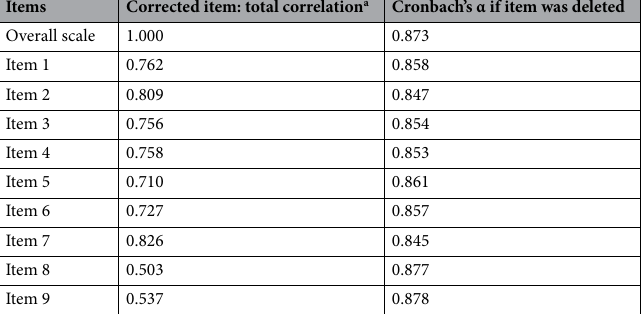
Table 2. The internal consistency of CAIT-C. CAIT-C Chinese version of Cumberland Ankle Instability Tool. a Calculated by the Spearman’s correlation coefficient of the items with total score.